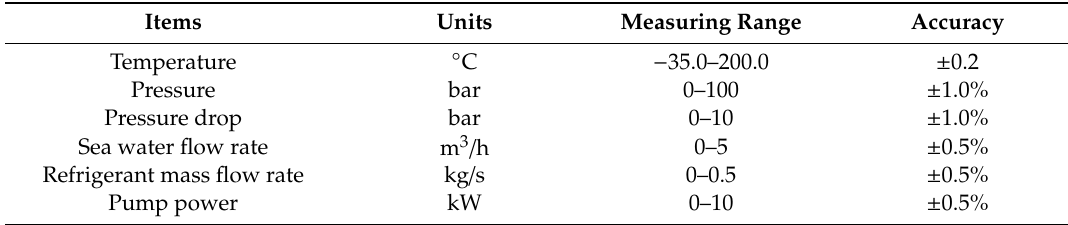
Table 2. Measuring the operating parameters of the instrument.